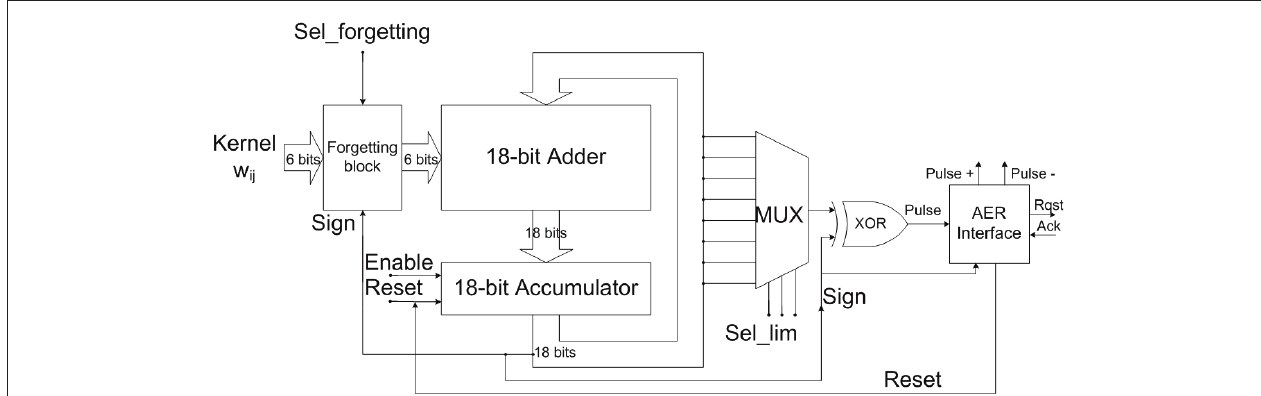
FIgure 21 | block diagram of a fully digital I&F neuron. Calibrated current source, pulsing current mirrors, and integration capacitors of Figure 20 , are replaced by digital adder and accumulator